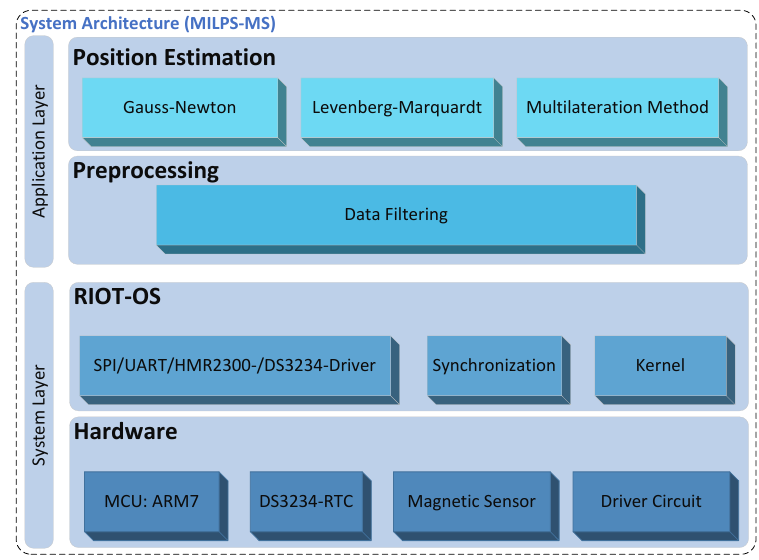
Figure 9. MILPS: System architecture of the Mobile Station